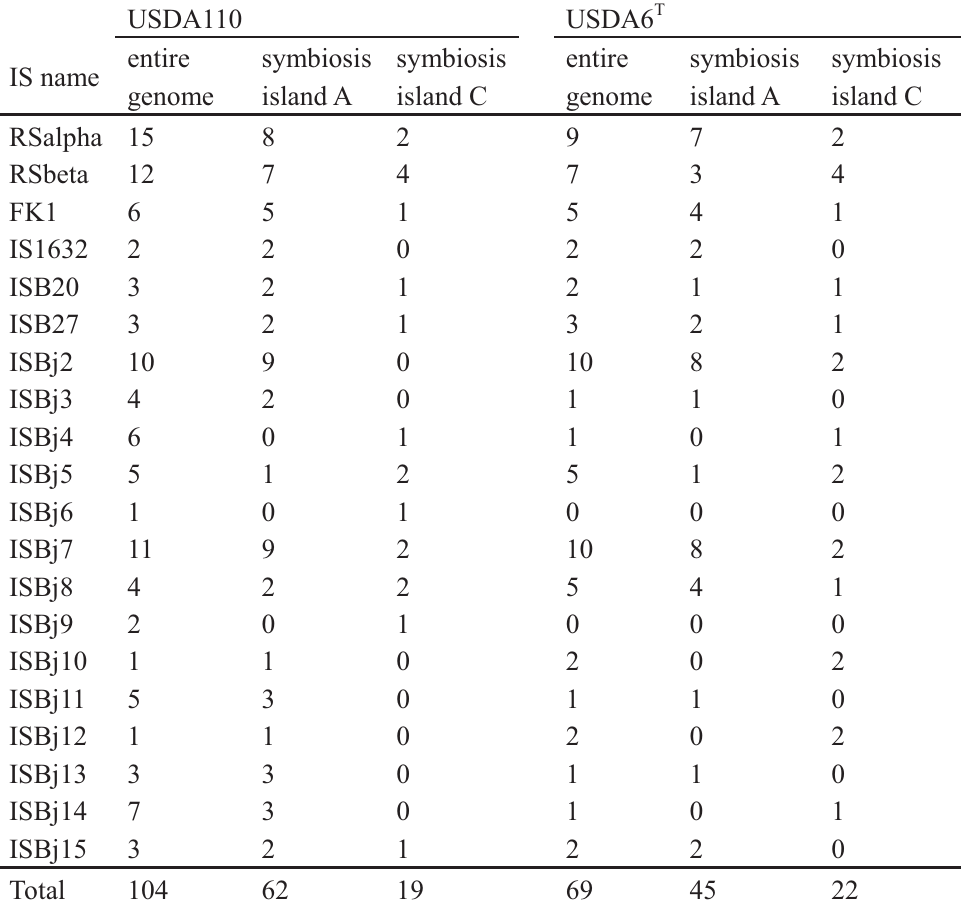
Table 4. Distribution of Insertion Sequences (ISs) in the genomes of USDA6 T and